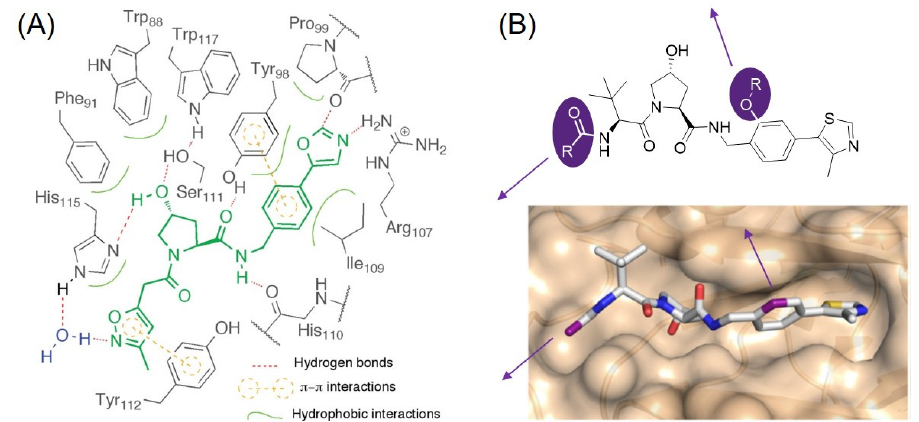
Figure 5. ( A ) Schematic illustrations showing the binding mode of the VHL ligand 17 . Reprinted with permission from ref. [33] (Copyright 2012 American Chemical Society). ( B ) Chemical structure of a representative VHL ligand analogue having two different linker positions. Reprinted with permission from ref. [37] (Copyright 2019 Springer Nature).